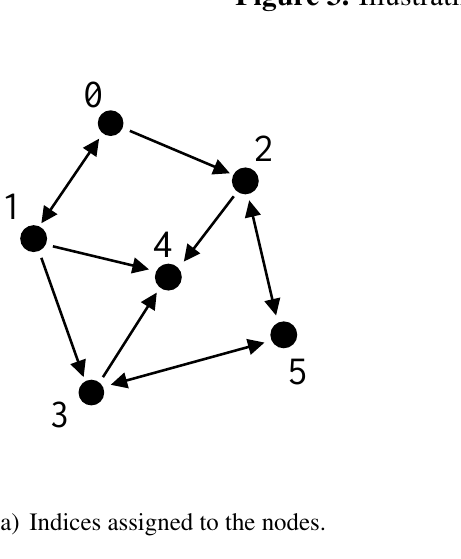
Figure 3. Illustrating Phase